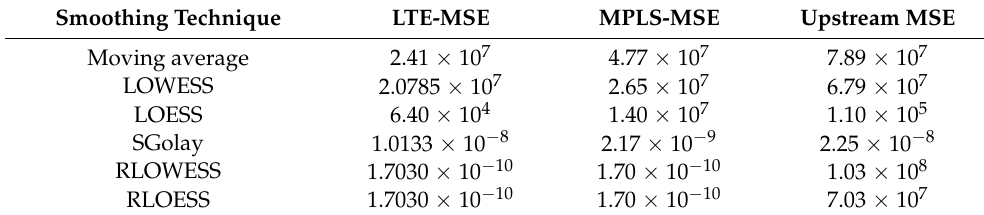
Table 5. Smoothing MSE.